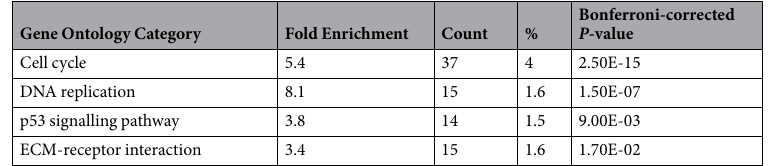
Table 1. Gene Ontology categories over-represented in the set of 988 DETs * . * Findings are ranked according to Bonferroni-corrected P